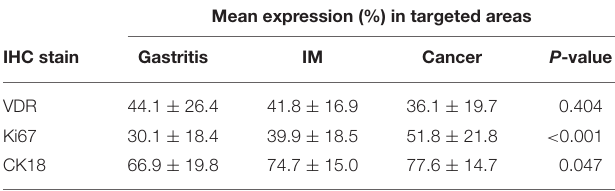
TABLE 2 | The mean expressions of VDR, Ki67, and CK18 among gastritis, IM and cancer. Mean expression (%) in targeted areas